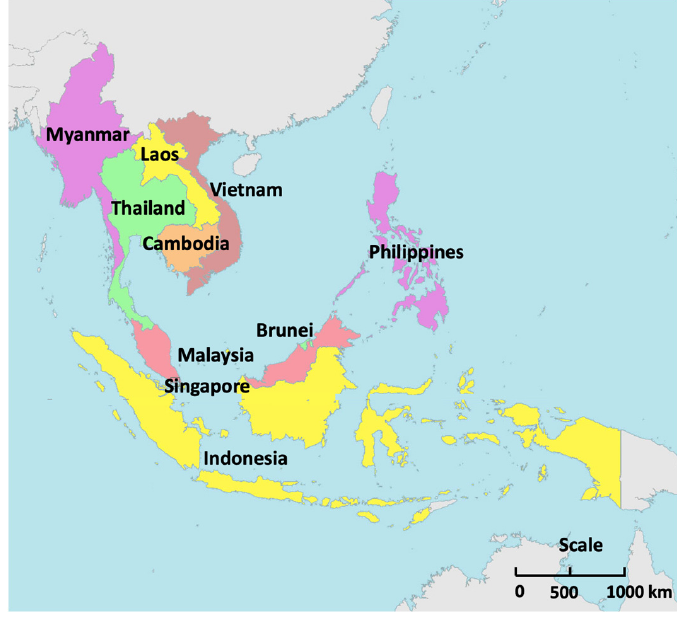
Figure 1. Map of ASEAN countries .